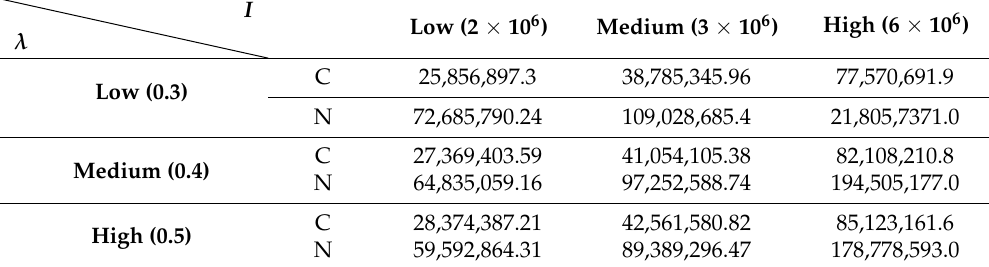
Table 6. The effect of changing incidence of diabetes and parameter λ on the results of C and N.